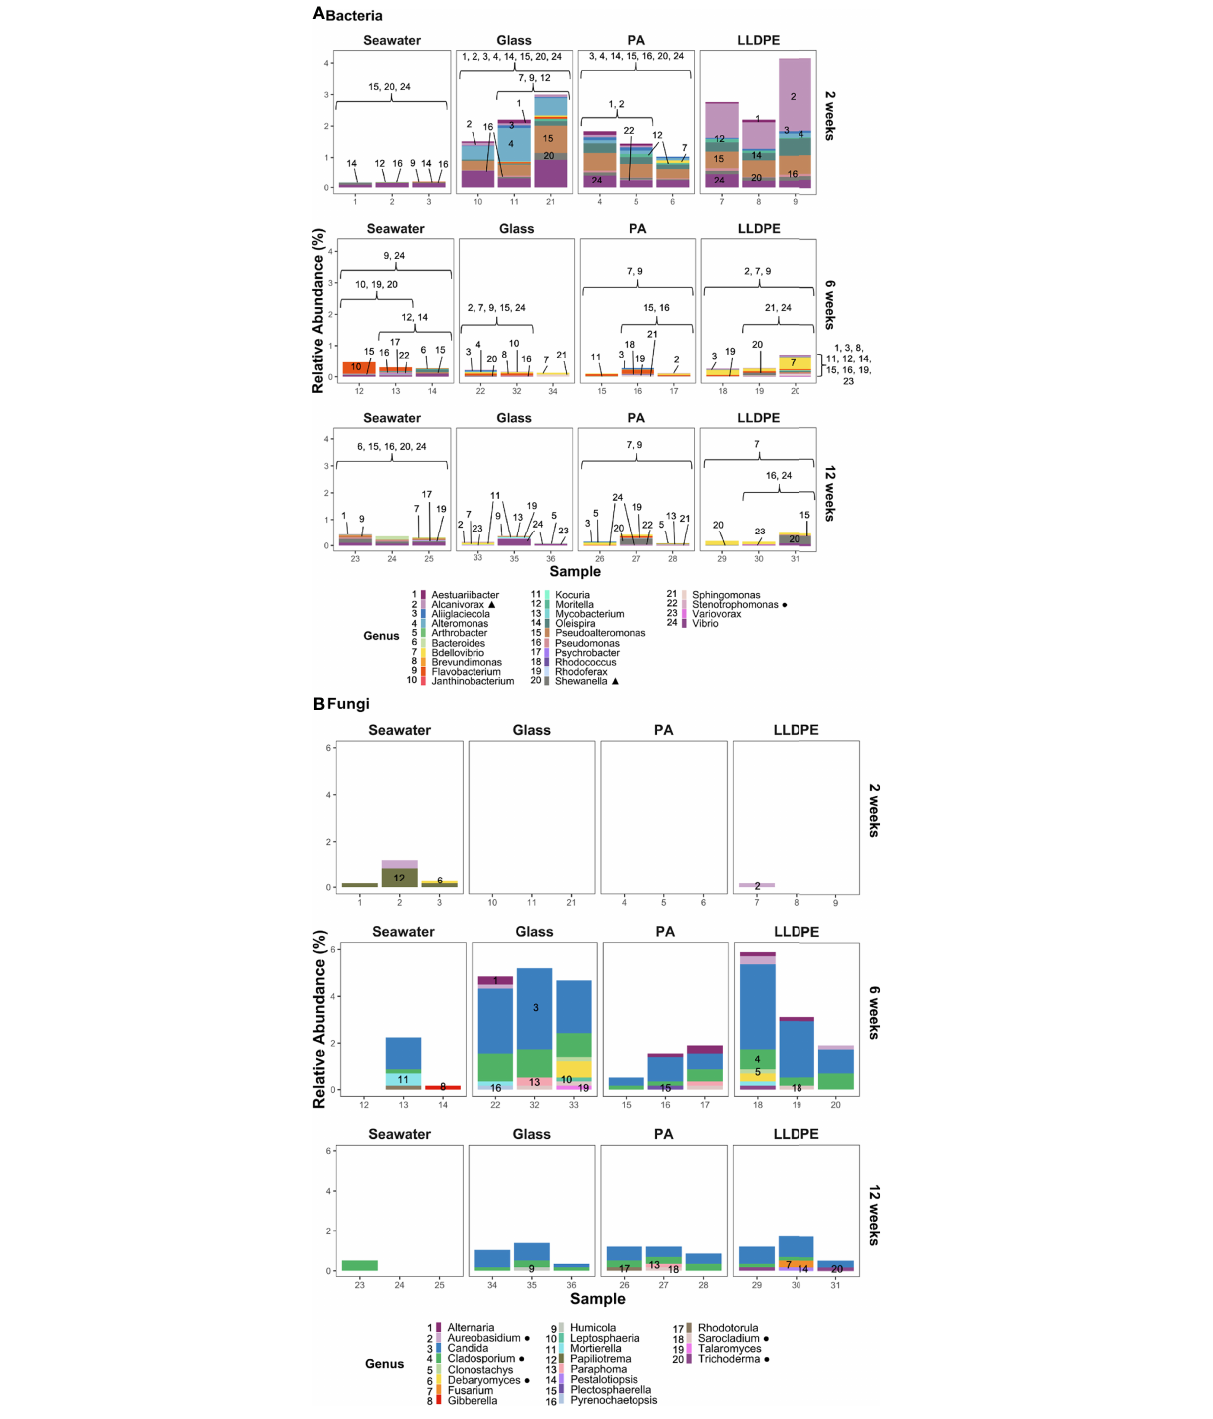
FIGURE 5 | Relative abundance of reported potential plastic-biodegrading genera present within (A) bacterial and (B) fungal communities on glass, nylon-6 (PA) and linear low-density polyethylene (LLDPE) and in seawater from the marine environment of Te Whakaraup ō -Lyttelton Harbour, Aotearoa-New Zealand. Each bar represents the stacked relative abundance for each sample from various substrates of different bio fi lm ages. Each colour and corresponding number represents a particular genus. Triangles ( ▲ ) represent genera containing ASVs determined in this study as potential indicators of LLDPE. Circles ( ● ) represent genera that contain microbes identi fi ed as a reported plastic biodegrader at the species